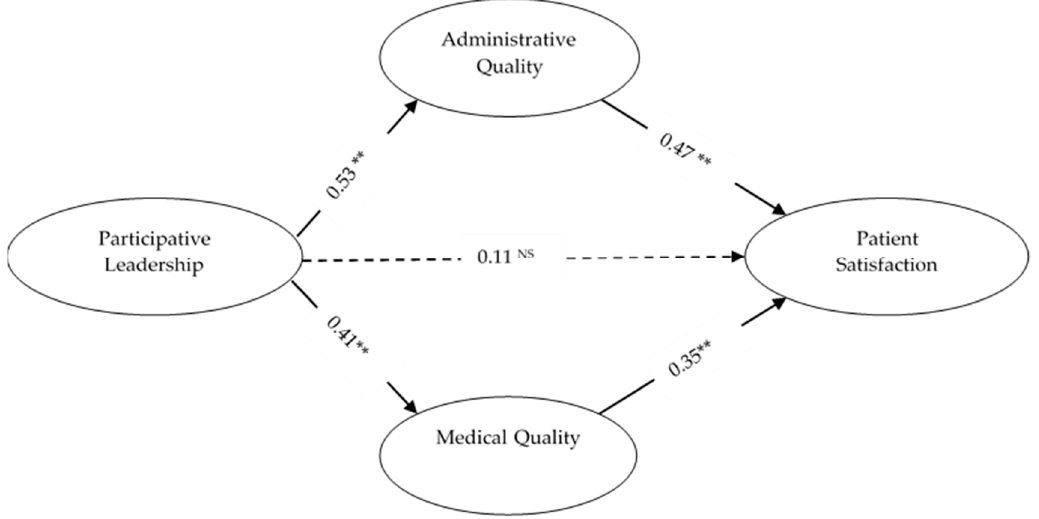
Figure 1. Mediation effects using SEM. ** p < 0.01, NS: Non significant Table 5. Bootstrapping analysis for indirect effects. Table 4. β estimates for testing hypotheses 1–4.